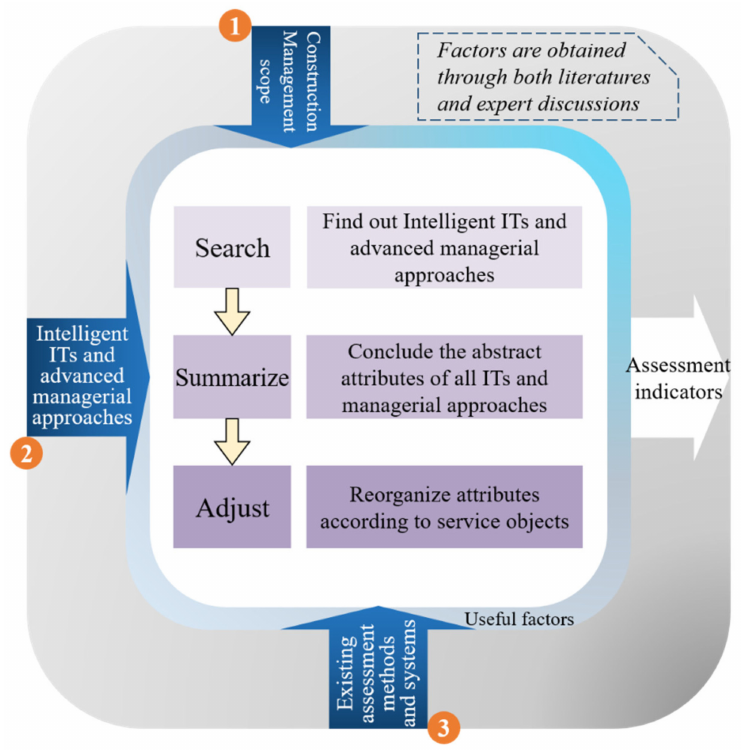
Figure 2. The indicator extraction